Question: Sum up the contents of this chart in one sentence.
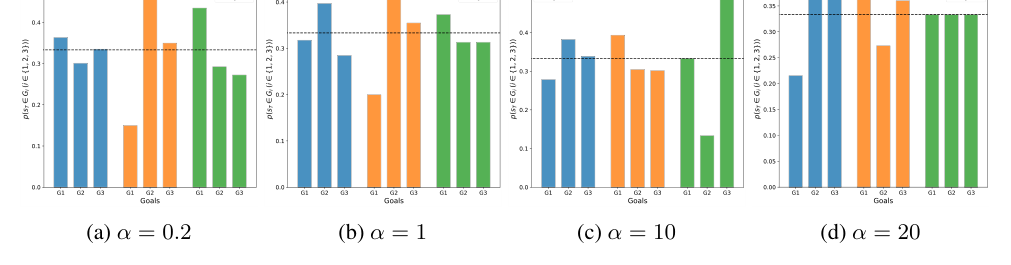
Answer: Distribution of reached goals for S2AC, SAC and SQL with different α’s. The x-axis denotes different goals. The y-axis represents the ratio of trajectories that reach the goal.